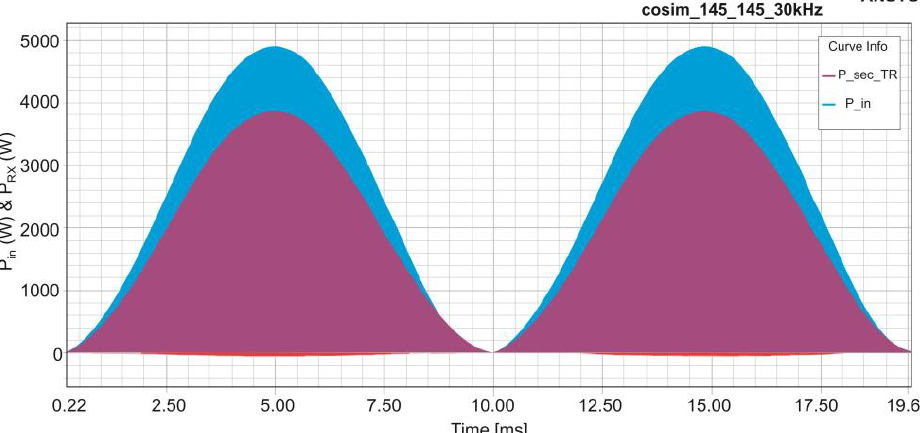
Figure 14. Transmitter (blue) and receiver (red) coil powers.